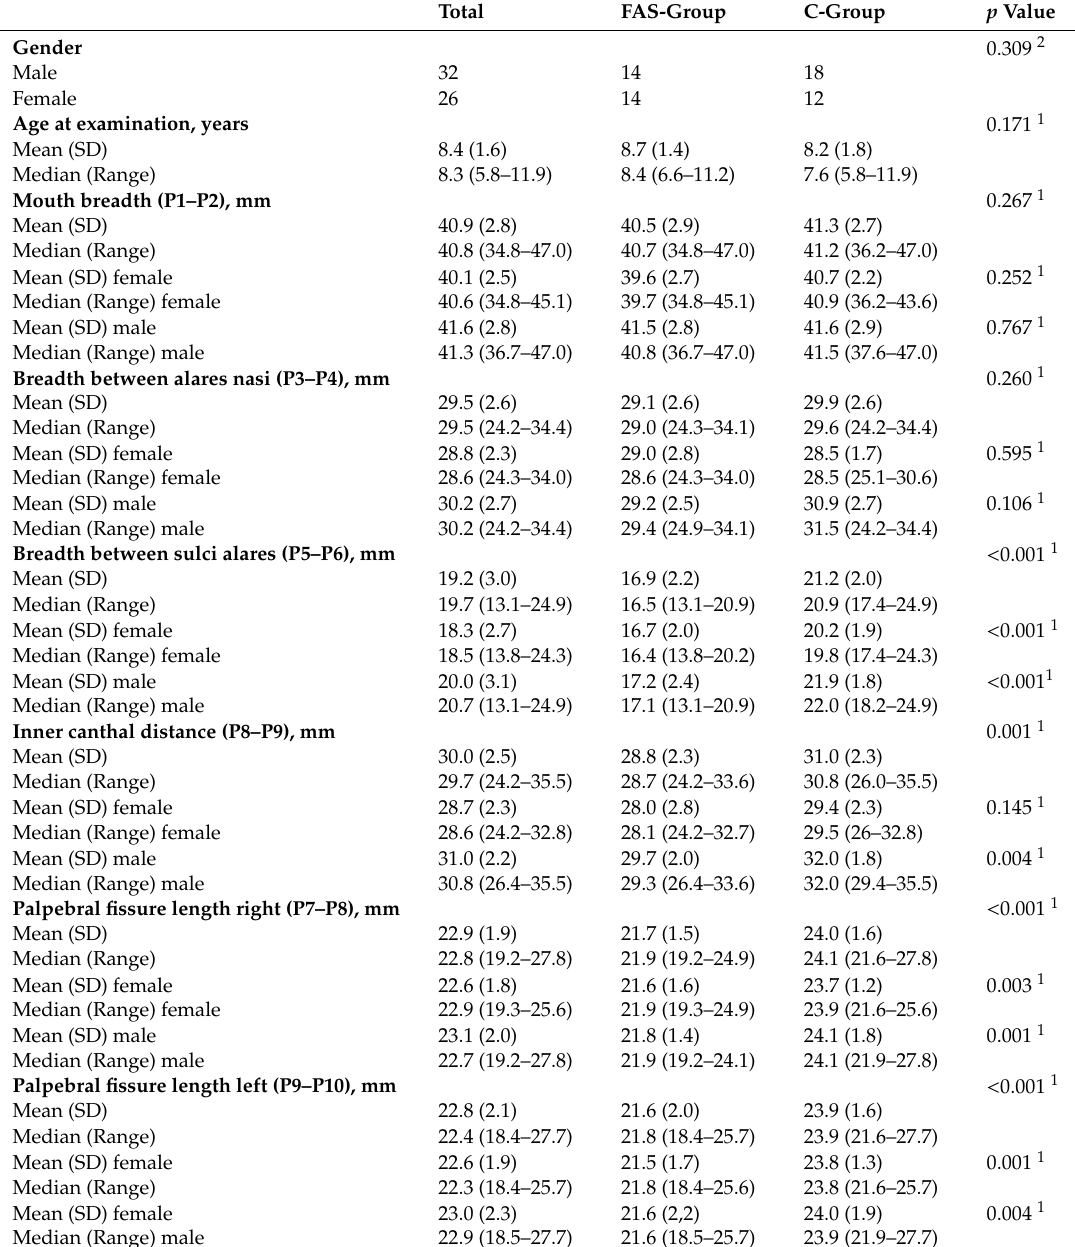
Table 1. Showing results for gender, age and determined study